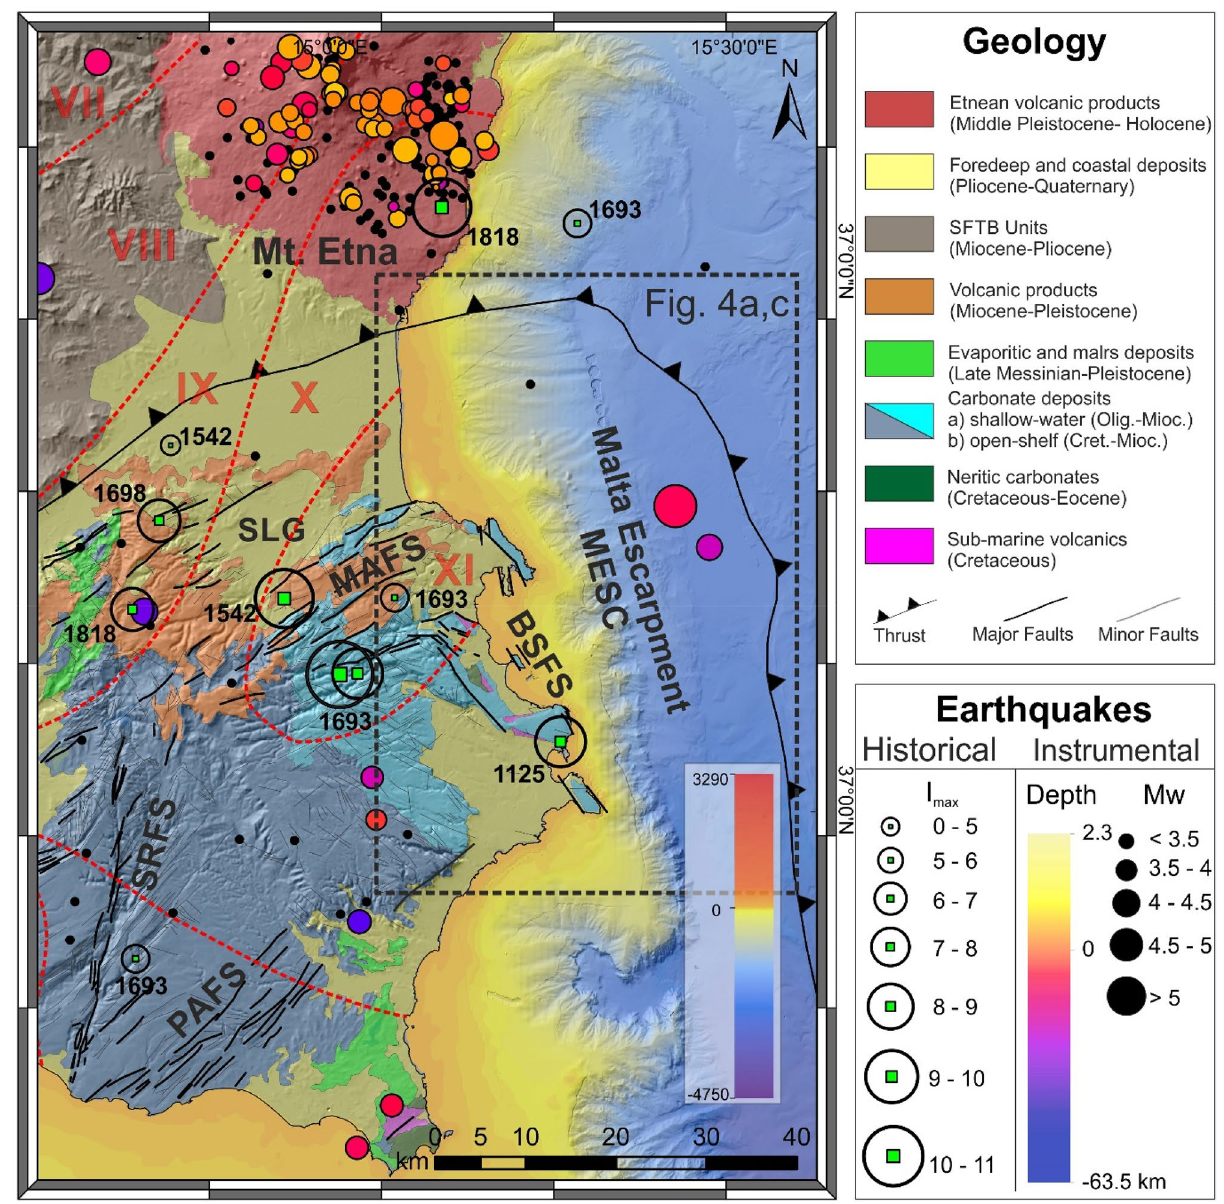
Figure 2. Structural setting of the Hyblean Plateau with major faults system (MAFS, Monterosso–Agnone Faults System; SRFS, Scicli–Ragusa Faults System; PAFS, Pozzallo–Avola Faults System; BSFS, Brucoli–Siracusa Faults Systems; SLG, Scordia Lentini Graben) with the location (empty circles) of Historical earthquakes (from CPTI 15 21 ), and instrumental seismicity with M > 2.5 events in the period 1981–2014 (from http:// istit uto. ingv. it/ index. php/ it/ archi vi-e- banche- dati—see also Scarfi et al. 22 ). Red dashed lines refer to the isoseismal map proposed by Barbano 23 for the January 11, 1693 earthquake. The map was obtained by co-authors through QGIS—software (version 3.14.16); https:// www. qgis. org/ it/ site/, license Creative Commons. Attribution-Share Alike 3.0 licence (CC BY-SA) integrated with ESRI World